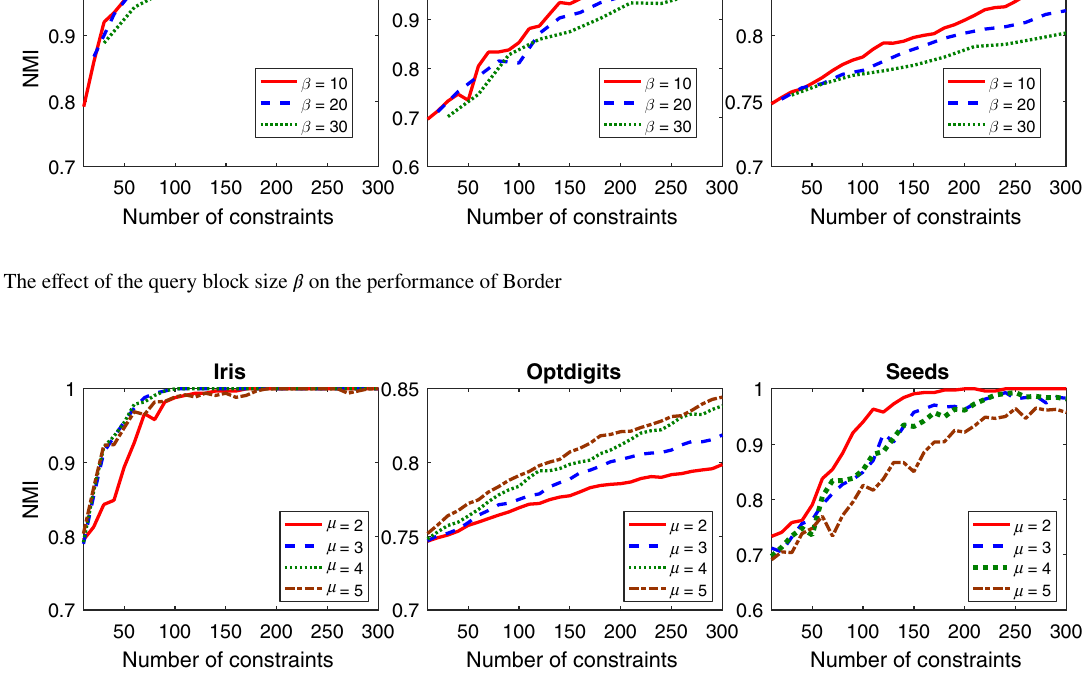
Fig. 12 The effect of the neighborhood size 𝜇 on the performance of